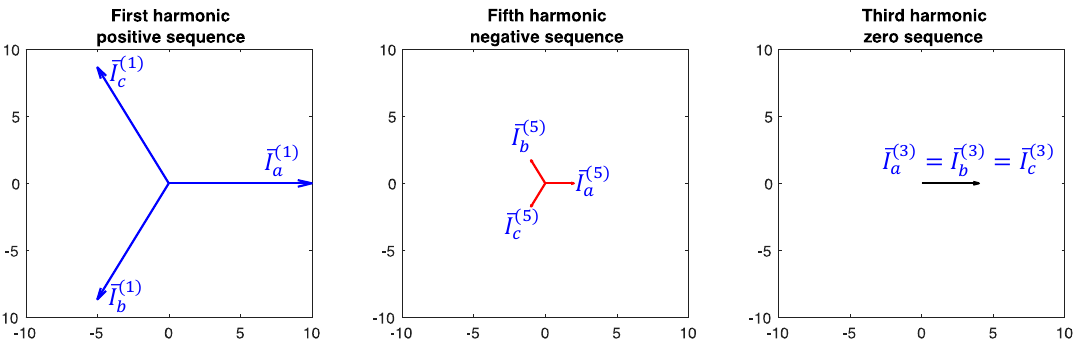
Figure 2. Phasor diagram taken at time t = 0 with respect to Figure 1.